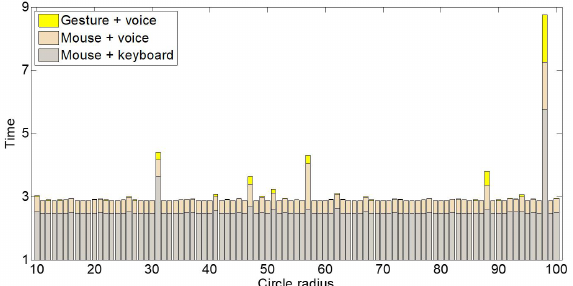
Fig. 5. Comparison results of the time taken by the three labeling modes